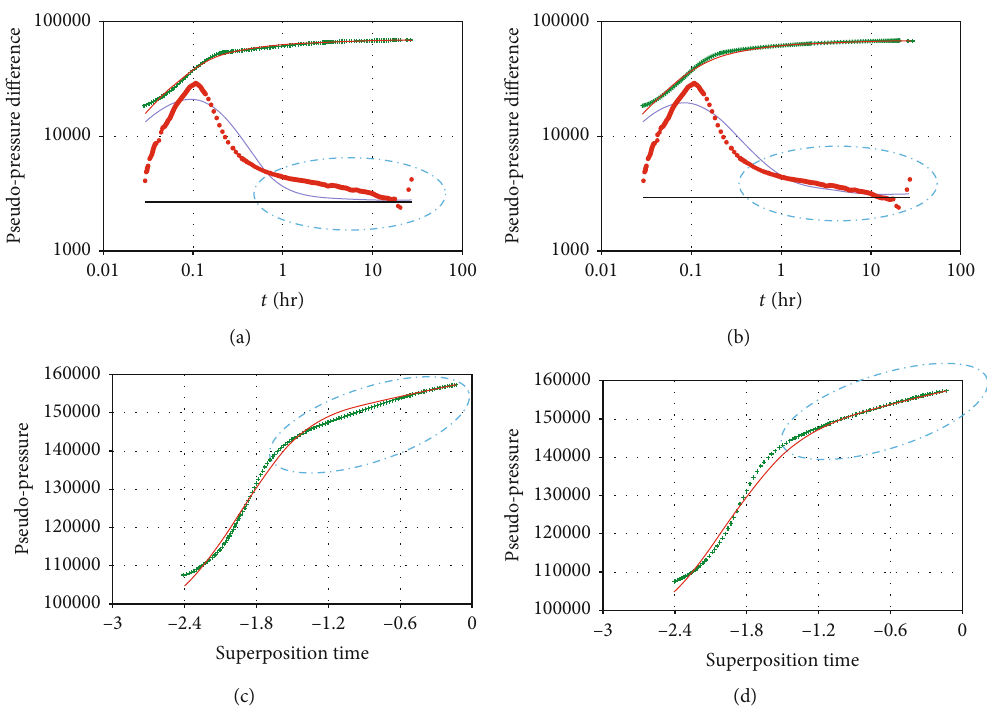
Figure 21: Comparison of interpretation results with and without considering the stress sensitivity e ff ect. (a, b) Well test interpretation results in the double logarithmic curve. (a) The interpretation result without considering the stress sensitivity e ff ect. (b) The interpretation result considering the stress sensitivity e ff ect. (c, d) Well test interpretation results in the semilogarithm curve. (c) The interpretation result without considering the stress sensitivity e ff ect. (d) The interpretation result considering the stress sensitivity e ff